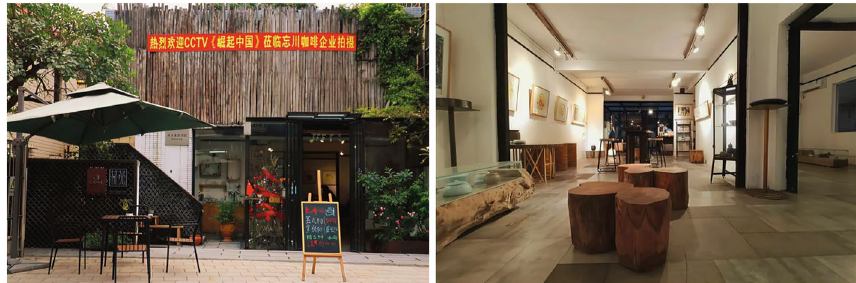
Fig. 1 Internal and external space of Wangchuan Cafe, 2020 (Source: the